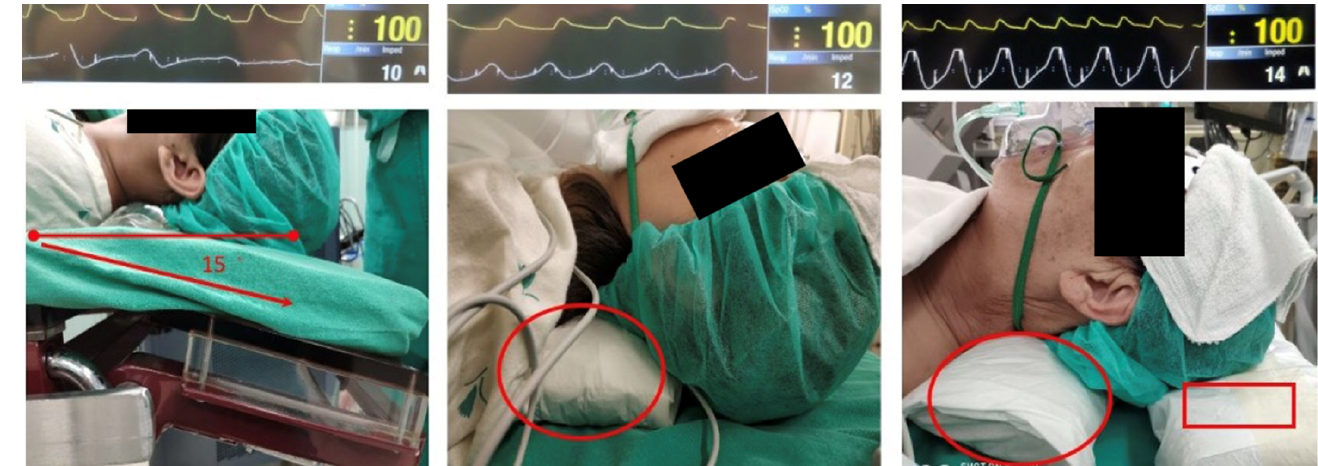
Figure 3. Upper airway position of patients for non-intubating anesthesia. Left: 15 ° head-down tilt only. Middle: 15 ° head-down tilt with a neck roll pillow (indicated by the red circle). Right: 15 ° head-down tilt with a neck roll pillow and keeping the chin plane horizontally aligned by a headrest (indicated by the red square) to be able to optimize respiratory impedance.